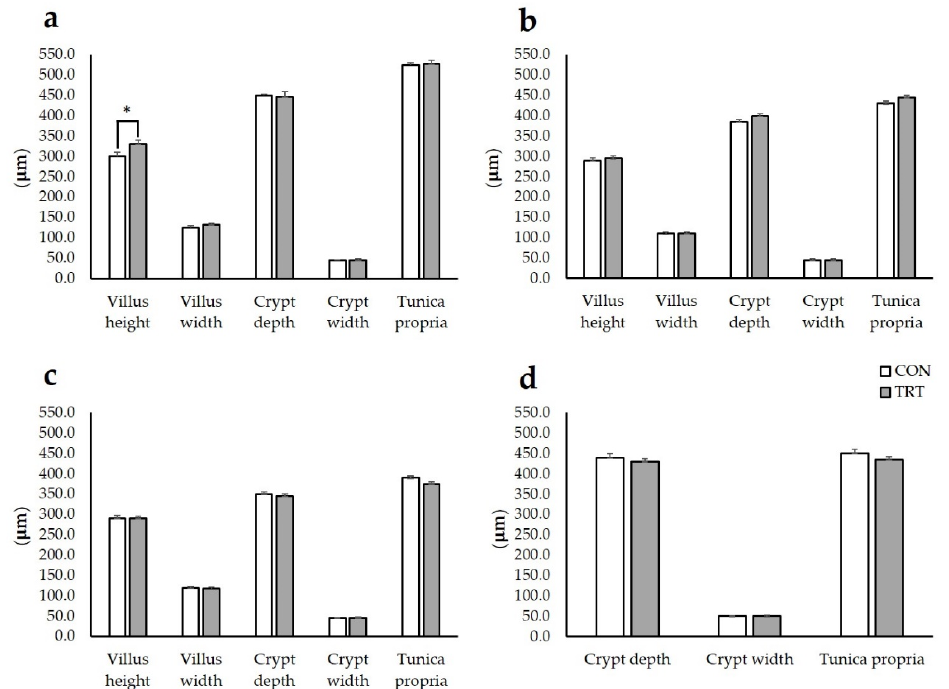
Figure 1. Effects of mannan oligosaccharides supplementation in post weaning piglets on GIT histometry. Data shown as LSMeans ± SEM. ( a ) duodenum, ( b ) jejunum, ( c ) ileum, and ( d ) colon; CON (n = 10): animals receiving the basal diet with no MOS supplementation; TRT (n = 10): animals receiving the basal diet with 0.2% MOS supplementation; LSMeans: least-square means; SEM: standard error of the mean; * significant at p < 0.05.